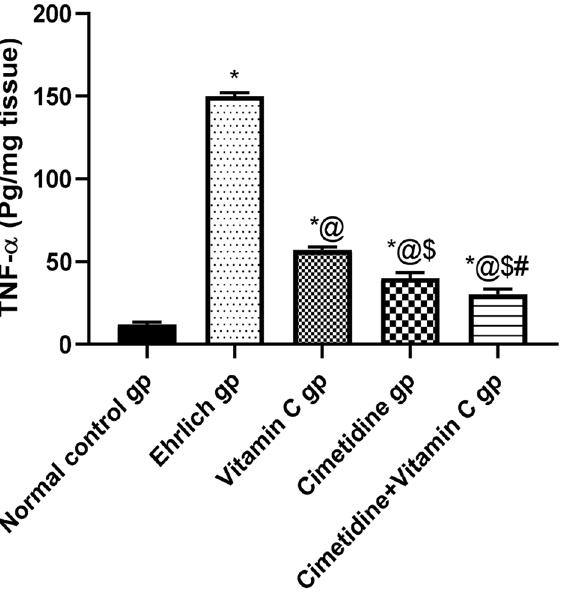
Figure 7. The changes in the tissue level of TNF-α following treatment with cimetidine at a dose of 200 mg/kg/ day, vitamin C at a dose of 4 g/kg/day, and their combination for 15 days after Ehrlich induction of breast cancer in mice. Data are presented as mean ± SD.* is significantly different from the normal control group, P < 0.05. @ is significantly different from Ehrlich untreated group, P < 0.05. $ is significantly different from the vitamin C-treated group, P < 0.05. # is significantly different from the cimetidine-treated group, P < 0.05.